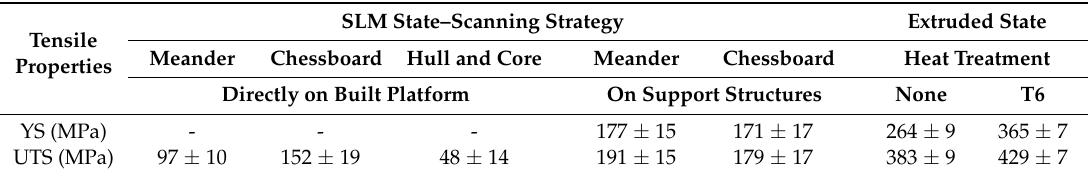
Table 2. Results of tensile